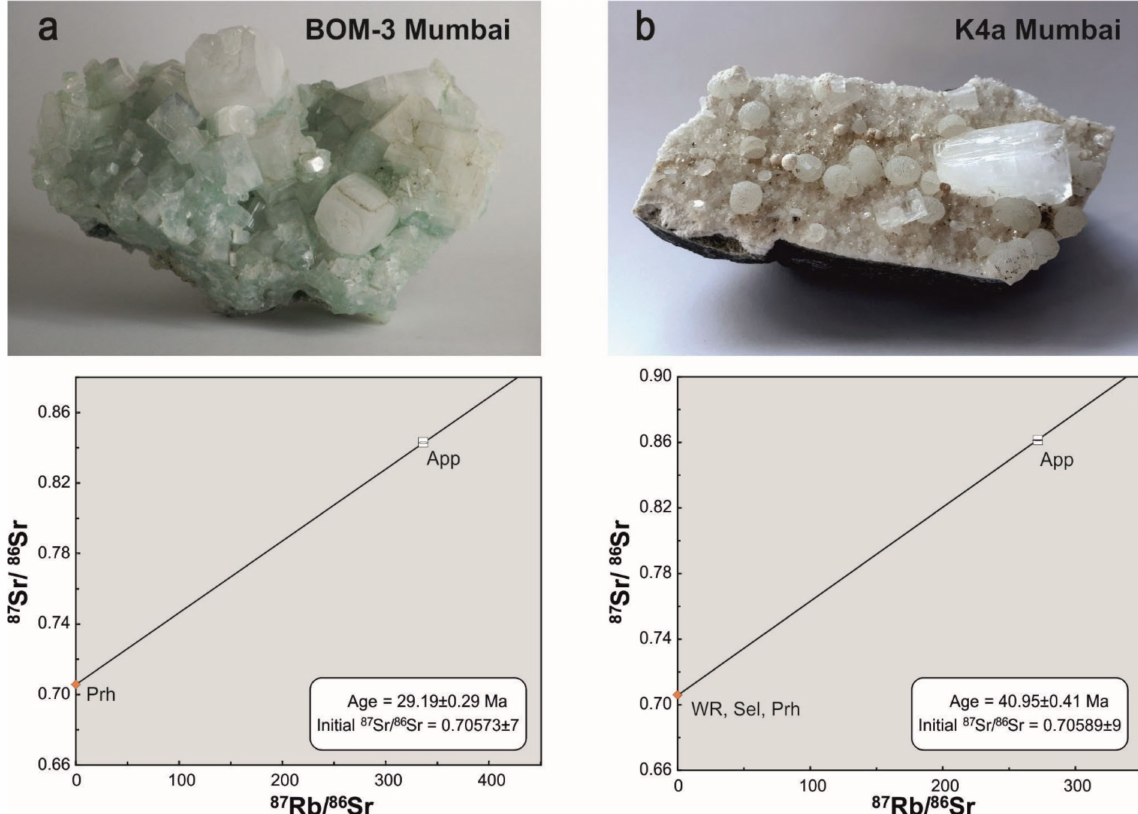
Figure 9. Rb-Sr age data from Salsette Island. ( a ) Sample BOM-3 derived from a void space within hyaloclastite breccia of the Kurar quarry. Blocky apophyllite is grown on greenish prehnite (wide of specimen 10 cm). The age was calculated from prehnite (Prh) and apophyllite-K (App). ( b ) Sample K4a was collected from a pillow cavity from the Kurar quarry. In contact with the cavity, the basalt shows a 3-mm-thick spilitized selvage. The secondary mineralization includes a thin layer mostly consisting of laumontite and calcite, overgrown by quartz. On top, spherical prehnite aggregates and up to 2 cm large apophyllite-K crystals are situated (wide of specimen 8 cm). For age calculation, basaltic whole rock (WR), selvage (Sel), prehnite (Prh), and apophyllite-K (App) were used. Both calculations are based on an error of ± 1% on the 87 Rb/ 86 Sr